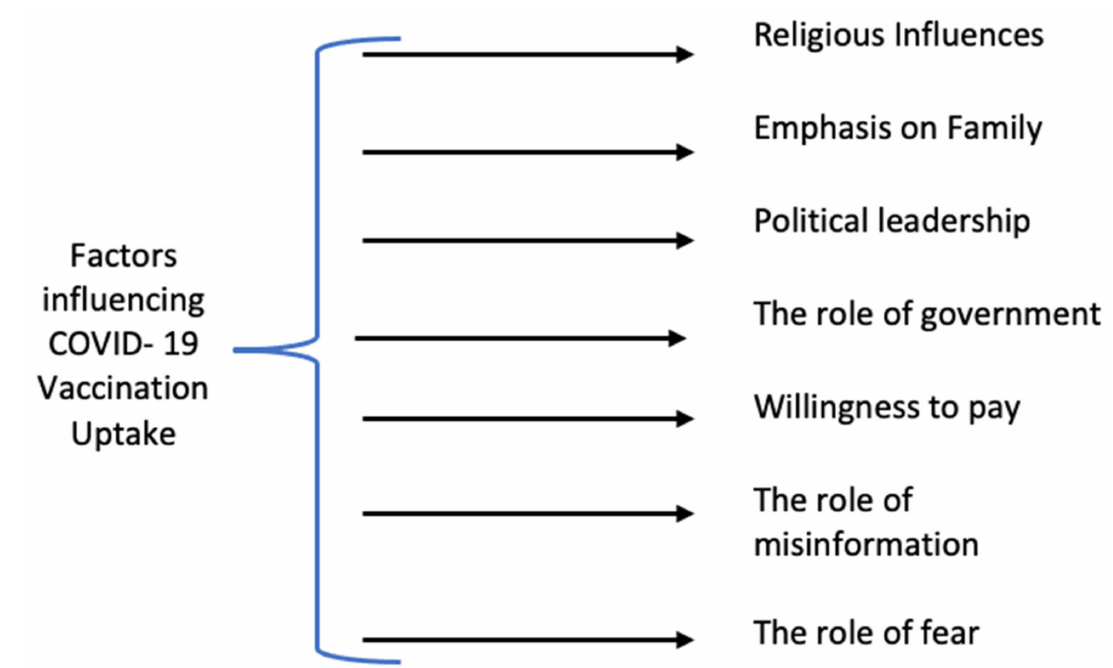
Figure 1. Seven themes affecting vaccination drive in